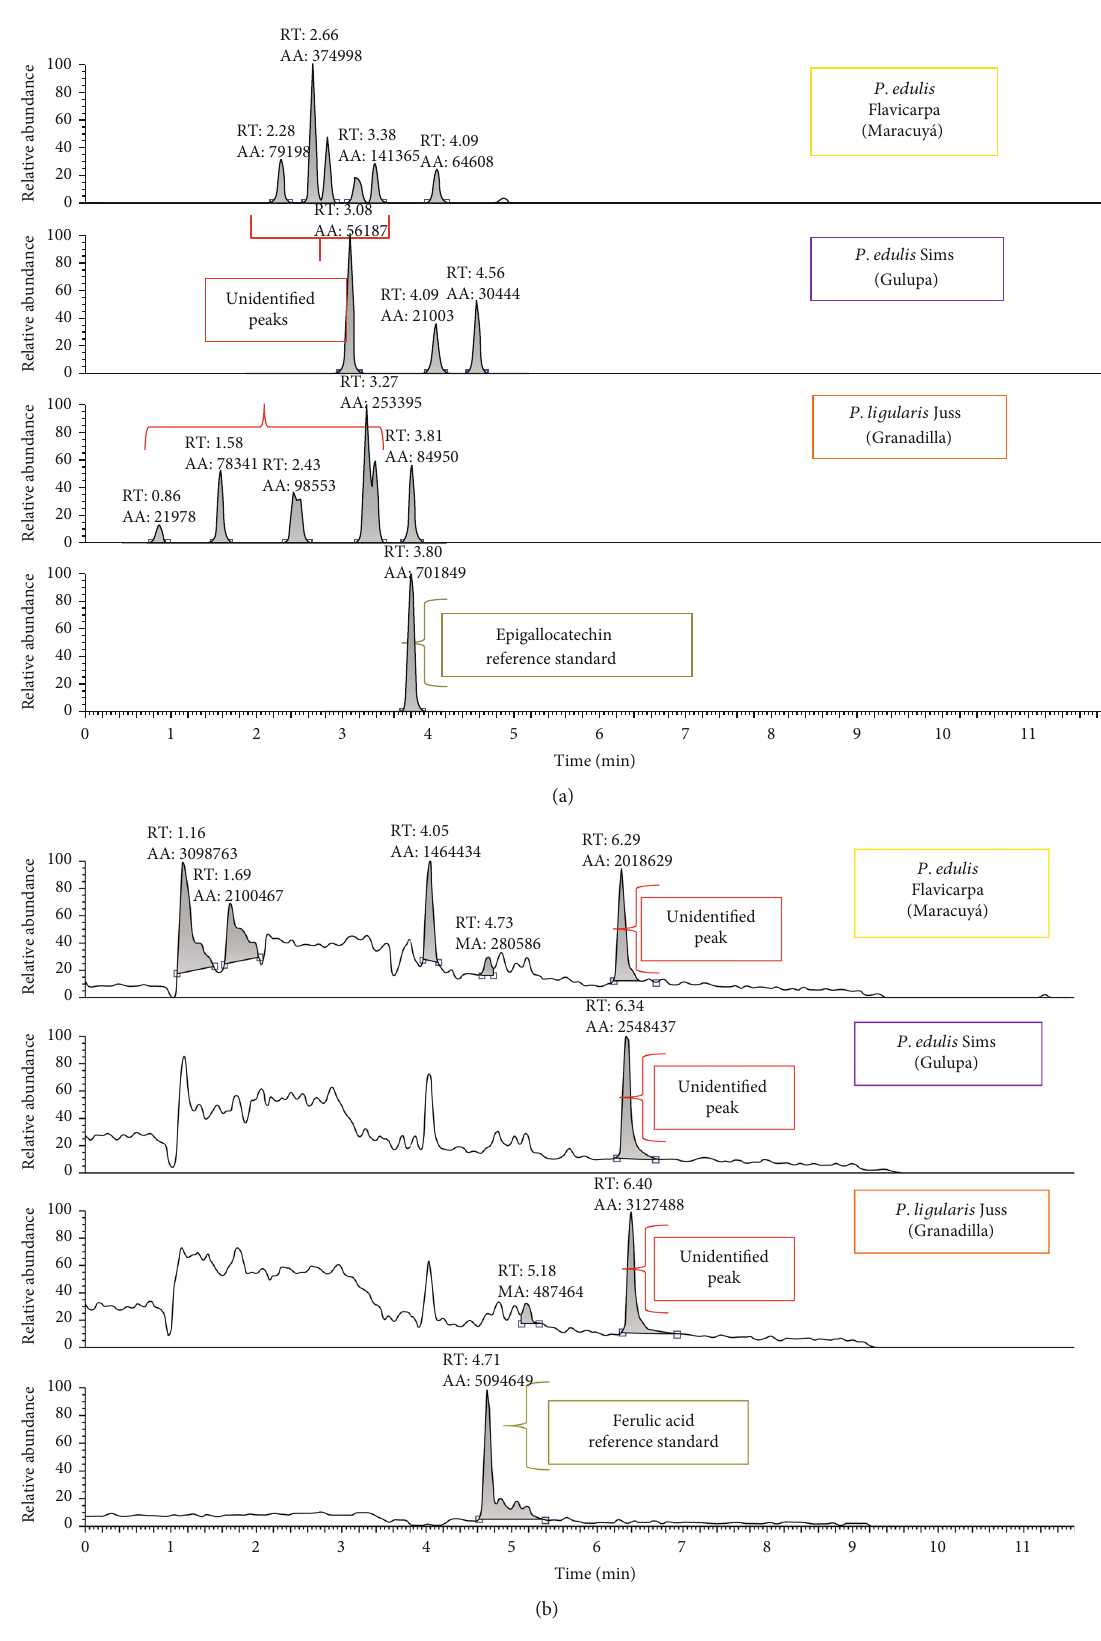
Figure 4: (a) Chromatograms for Passi fl ora acetone extracts with epigallocatechin reference standard. (b) Colombian Passi fl ora extracts with ferulic acid standard and several unidenti fi ed peaks in both